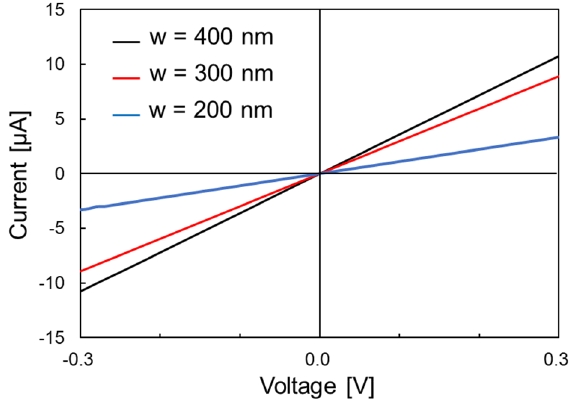
Figure 5. I–V characteristics of GNRs with widths (w) of 400, 300, and 200 nm.